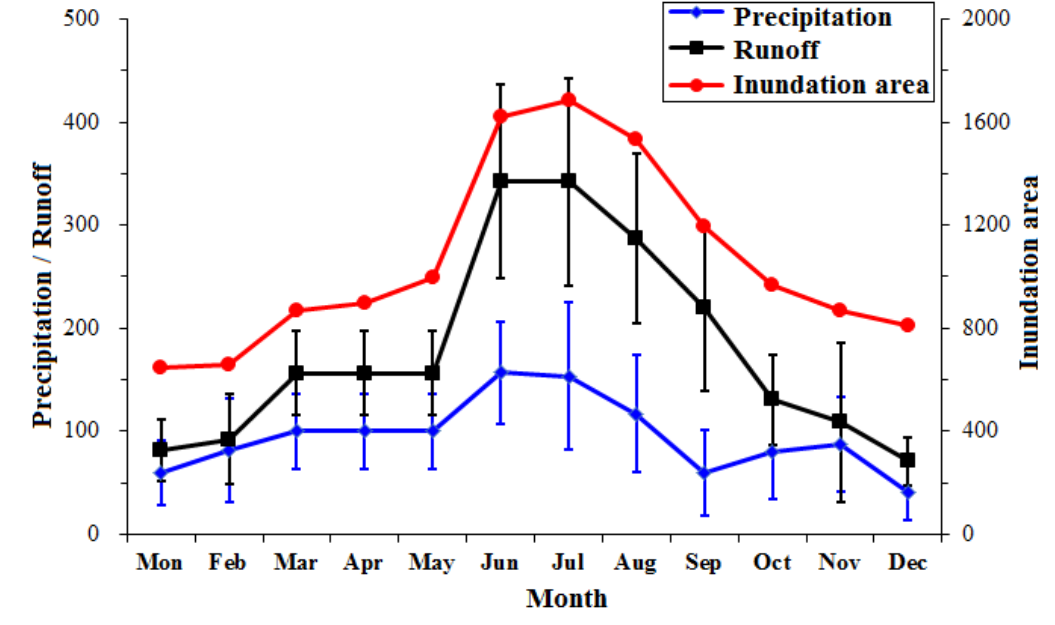
Figure 6. Changes in the average monthly precipitation, runoff, and inundation areas obtained from MODIS data between 2000 and 2012 in the Dongting Lake. The error bars represent standard deviations of precipitation and runoff. (Precipitation: mm; Runoff: 10 8 m 3 ; Inundation area: km 2